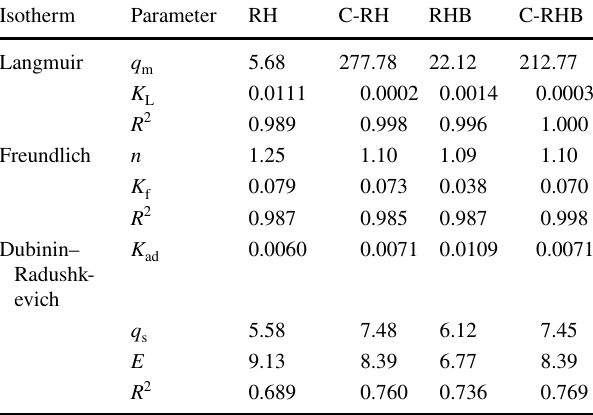
Fig. 3 Adsorption of nitrate 30–3000 mgN/l onto RH (open circle), RHB (filled circle), C-RH (open square), and C-RHB (filled square) at 25 ± 1 °C, initial pH of 7.0 ± 0.5